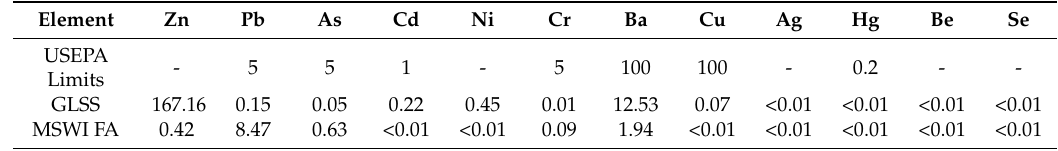
Figure 2. XRD patterns of the MSWI FA, GLSS, and geopolymer matrices. Table 2. TCLP leaching values of the GLSS and MSWI FA samples.